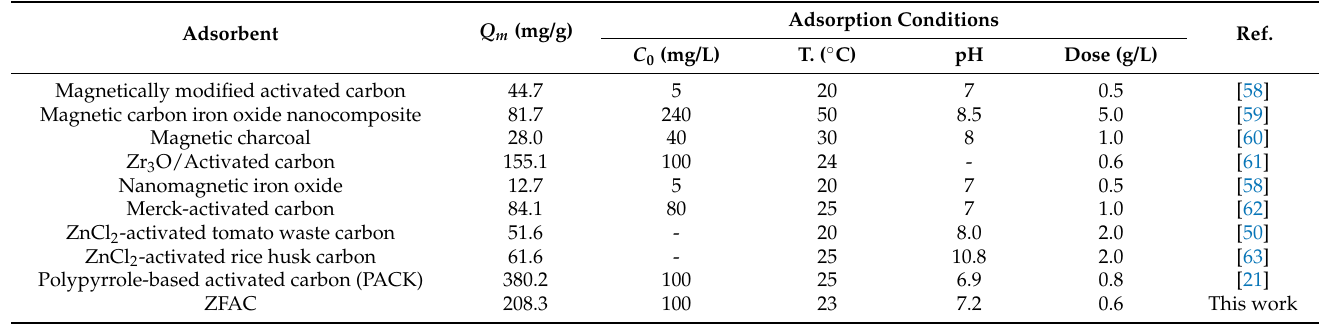
Table 6. Comparison of the ZFAC performance with various reported adsorbents on removal of CV dye from polluted water.